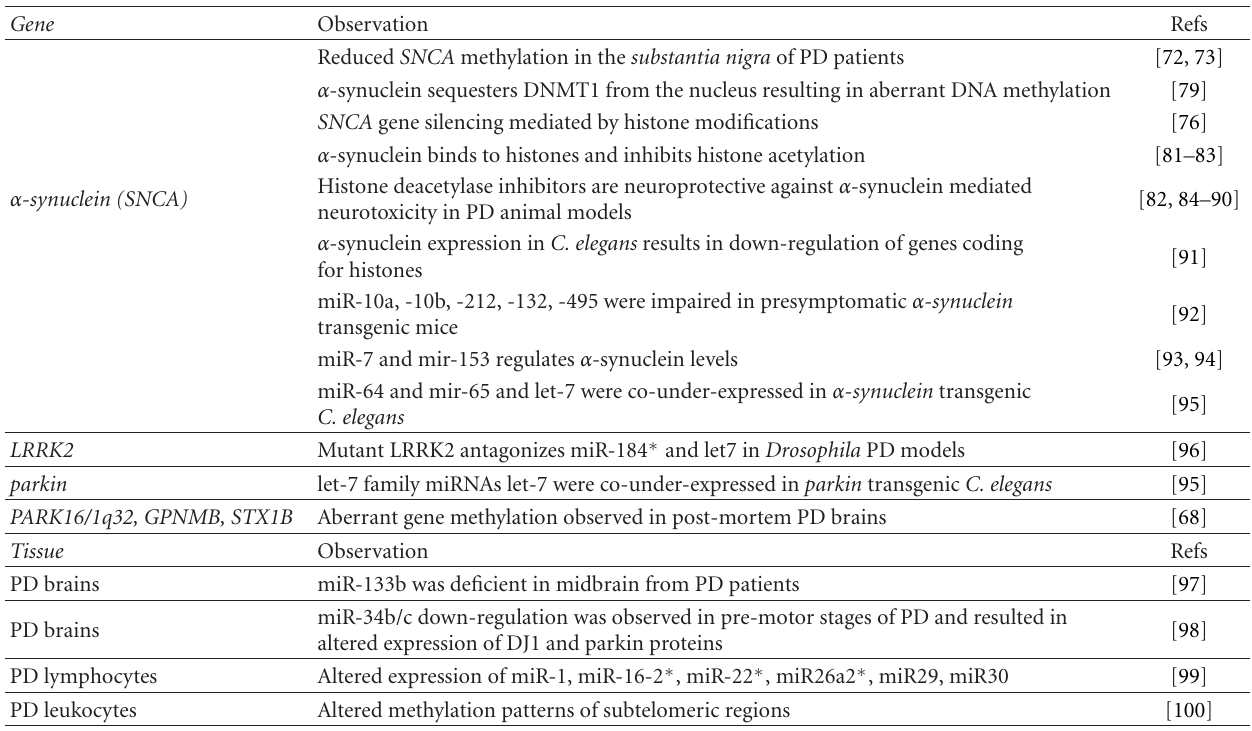
Table 4: Epigenetic changes of PD related genes or PD